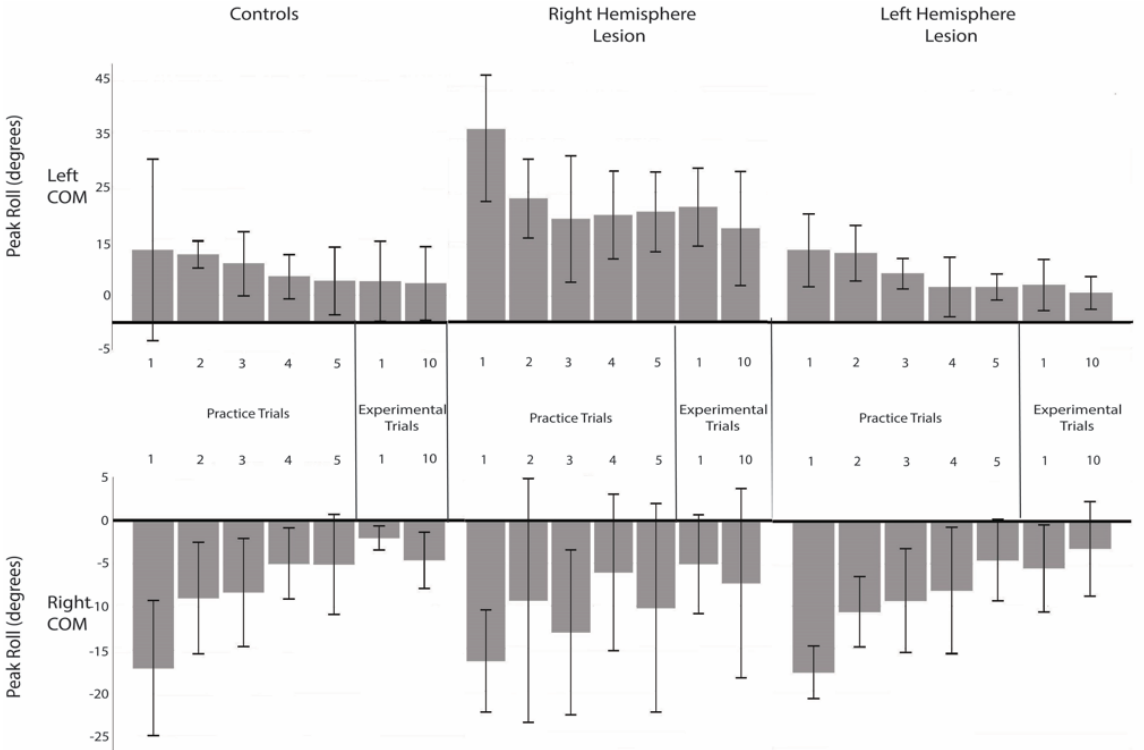
Figure A1. Mean peak object roll for each group for the left and right center of mass (COM) locations for the practice trials and the first and last experimental